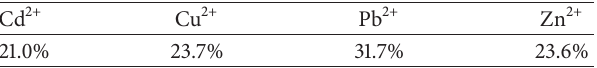
Table 3: Average participation in total adsorption amount for Cd 2+